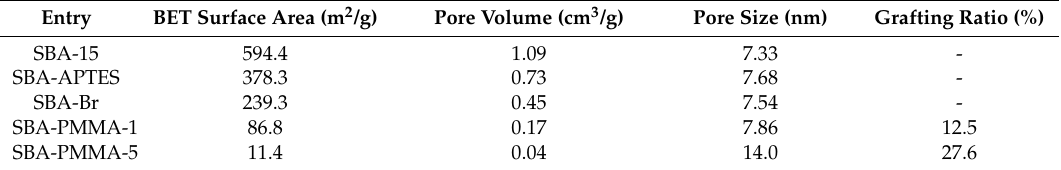
Table 2. Results of BET surface area and total pore volume of SBA-15, SBA-APTES, SBA-Br, and